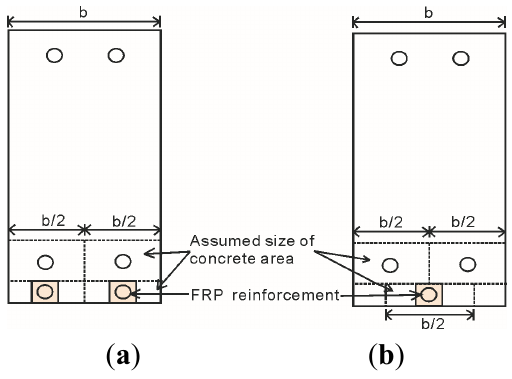
Figure 3. Assumed prism size. ( a ) Concrete size for two FRP reinforcement; ( b ) Concrete size for one FRP